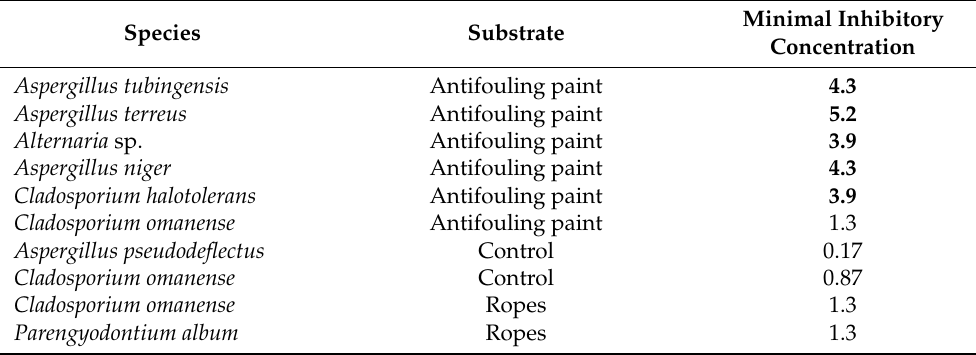
Table 2. The minimal inhibitory concentration of copper (II) sulfate ( µ g cm − 2 ) for fungal isolates from panels painted with the antifouling paint, not painted (control), and ropes. Highlighted